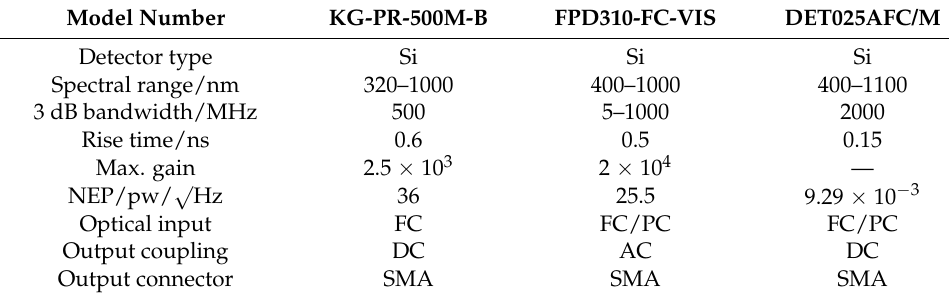
Table 2. Performance parameters of the